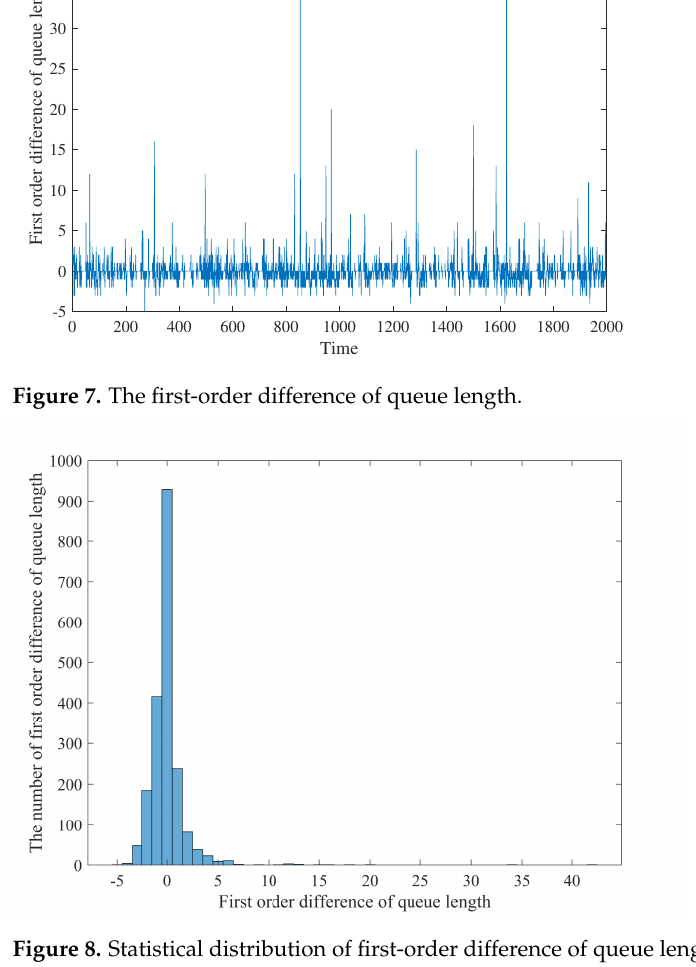
Figure 8. Statistical distribution of first-order difference of queue length.